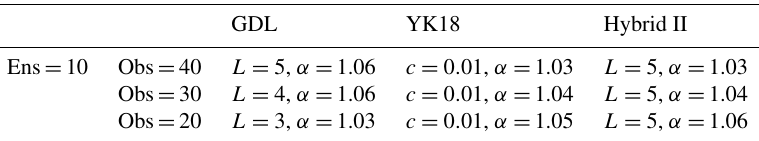
Table 3. The parameters used in the variant L96 model experiments given in Eqs. (4) and (7). The symbol α represents the multiplicative inflation parameter.